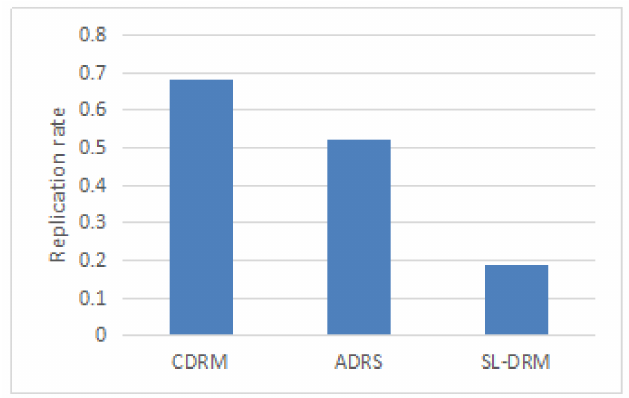
Figure 5. Replication rate of the dynamic replication